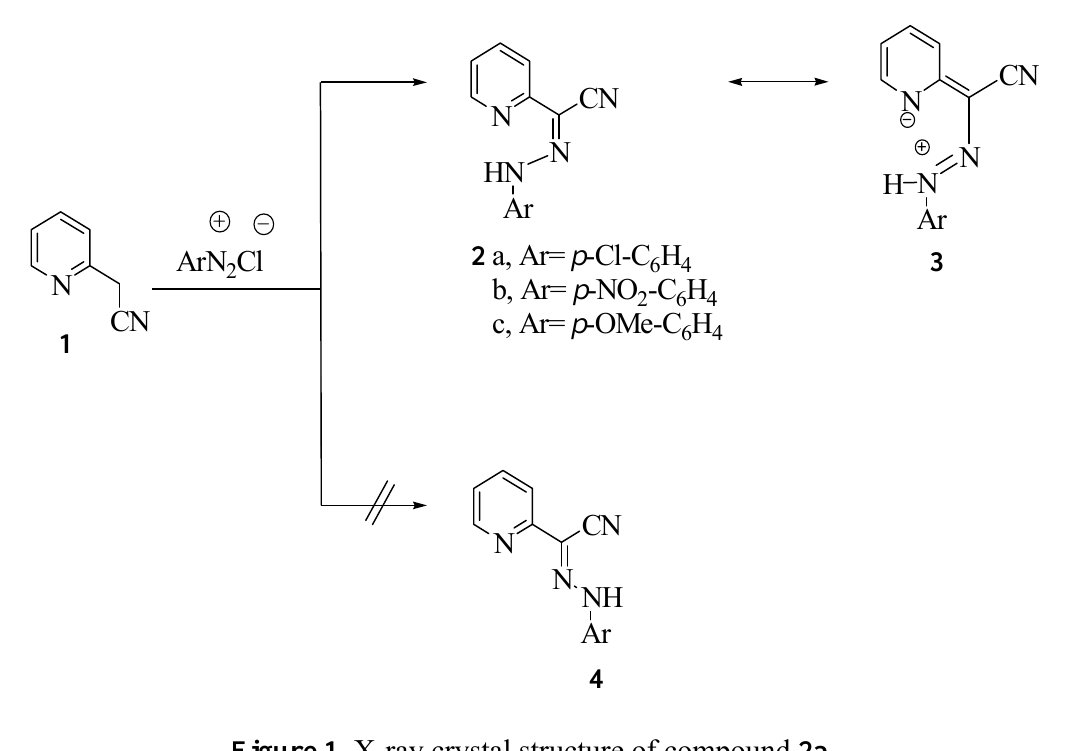
Figure 1. X-ray crystal structure of compound